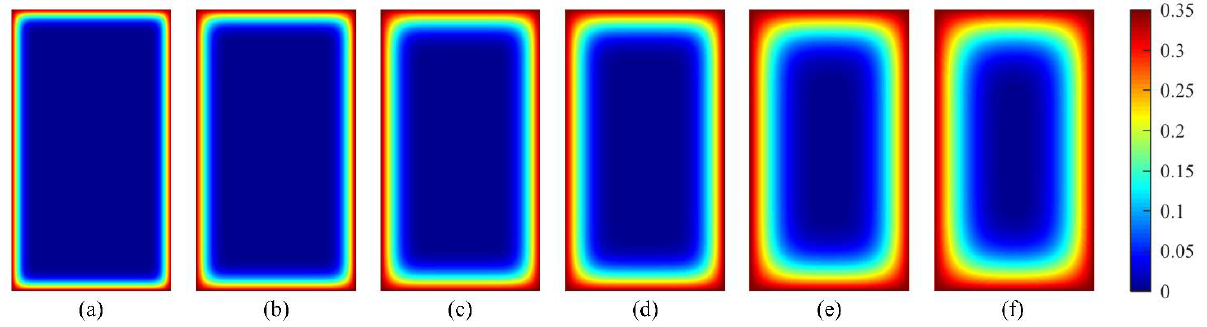
Figure 12. Simulation results (average value μ ) of the concentration of chloride ions in cross-section of PC concrete under different corrosion times: ( a ) t = 0.5 year; ( b ) t = 1 year; ( c ) t = 2 years; ( d ) t = 3 years; ( e ) t = 6 years; ( f ) t = 8 years.